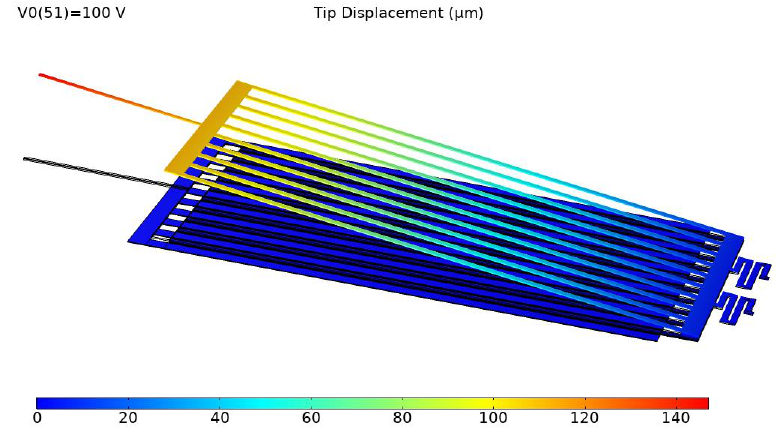
Figure 15. Contour plot of displacement along the z -axis. Table 2. Mechanical properties of single-crystal silicon.